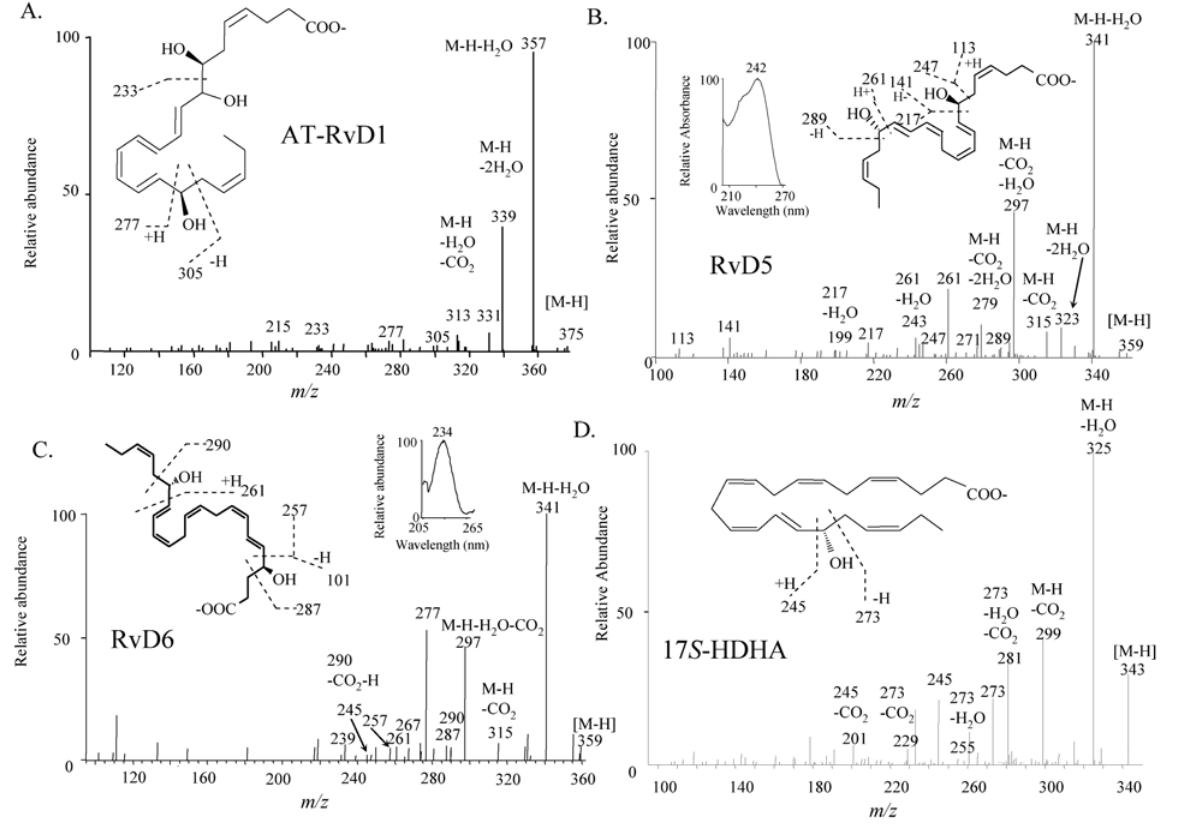
FIGURE 4. MS/MS spectra of biogenic resolvins, AT-Rv, and 17 S -HDHA. (A) AT-RvD1 (7 S , 8,17 R -triHDHA) was generated in AT inflammatory exudates[3]. (B) RvD5 was generated in trout brain cells[38]. (C) RvD6 was produced by human PMN; (inset) UV spectrum[13]. (D) 17 S -DHA was generated in trout